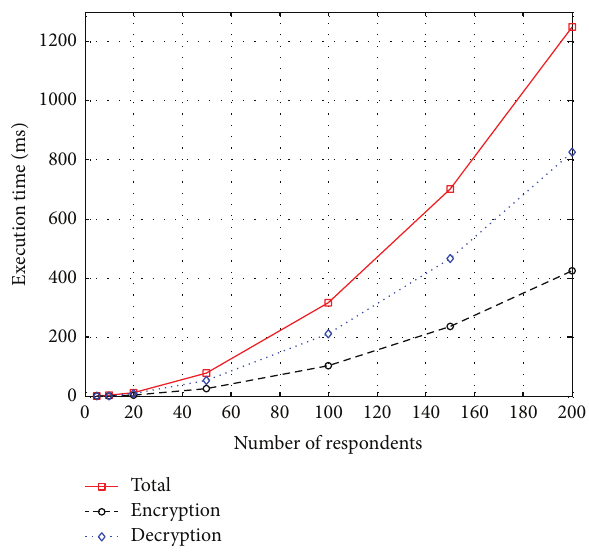
Figure 2: Performance of the proposed